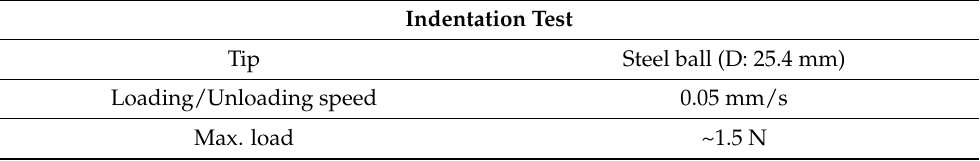
Figure 1. Schematic designs of ( a ) indentation tester and ( b ) reciprocating-type tribotester. Table 2. Indentation test